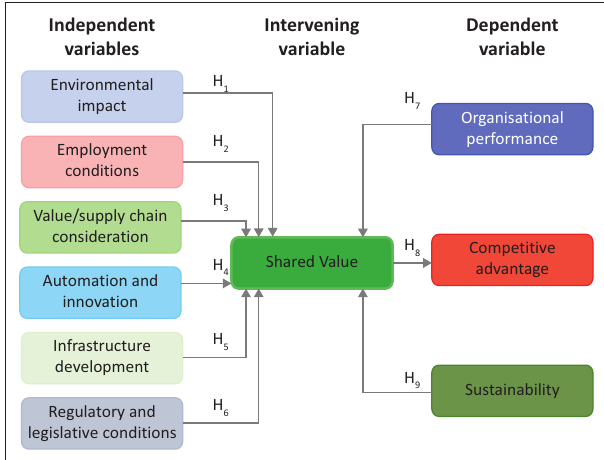
FIGURE 1: Hypothesised model of Shared Value within the South African mining